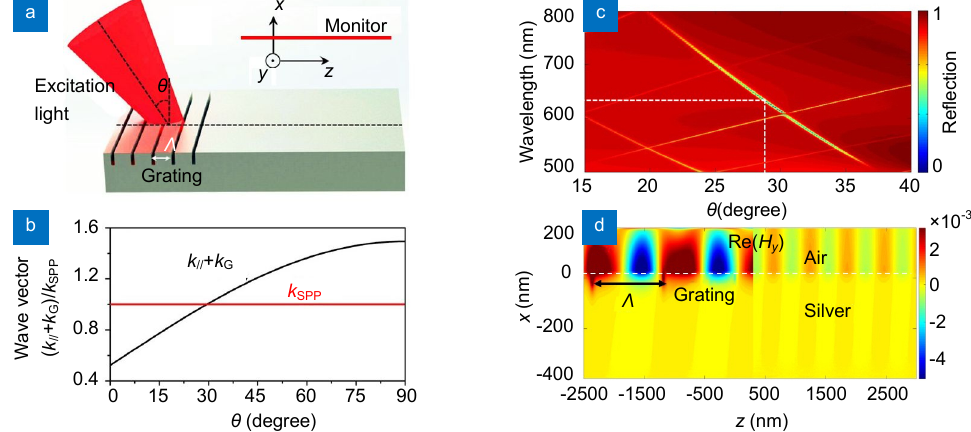
Fig. 2 | ( a ) Sketch map of SPPs excitation using a planar grating; ( b ) Dispersion relationship of SPPs and the grating coupling; ( c ) Reflection obtained from the field monitor located above the surface without grating; ( d ) Re( H y ) distribution of the grating-coupled SPPs generation and propagation along the silver-air interface with excitation wavelength at λ =632.8 nm and θ =28.5°.